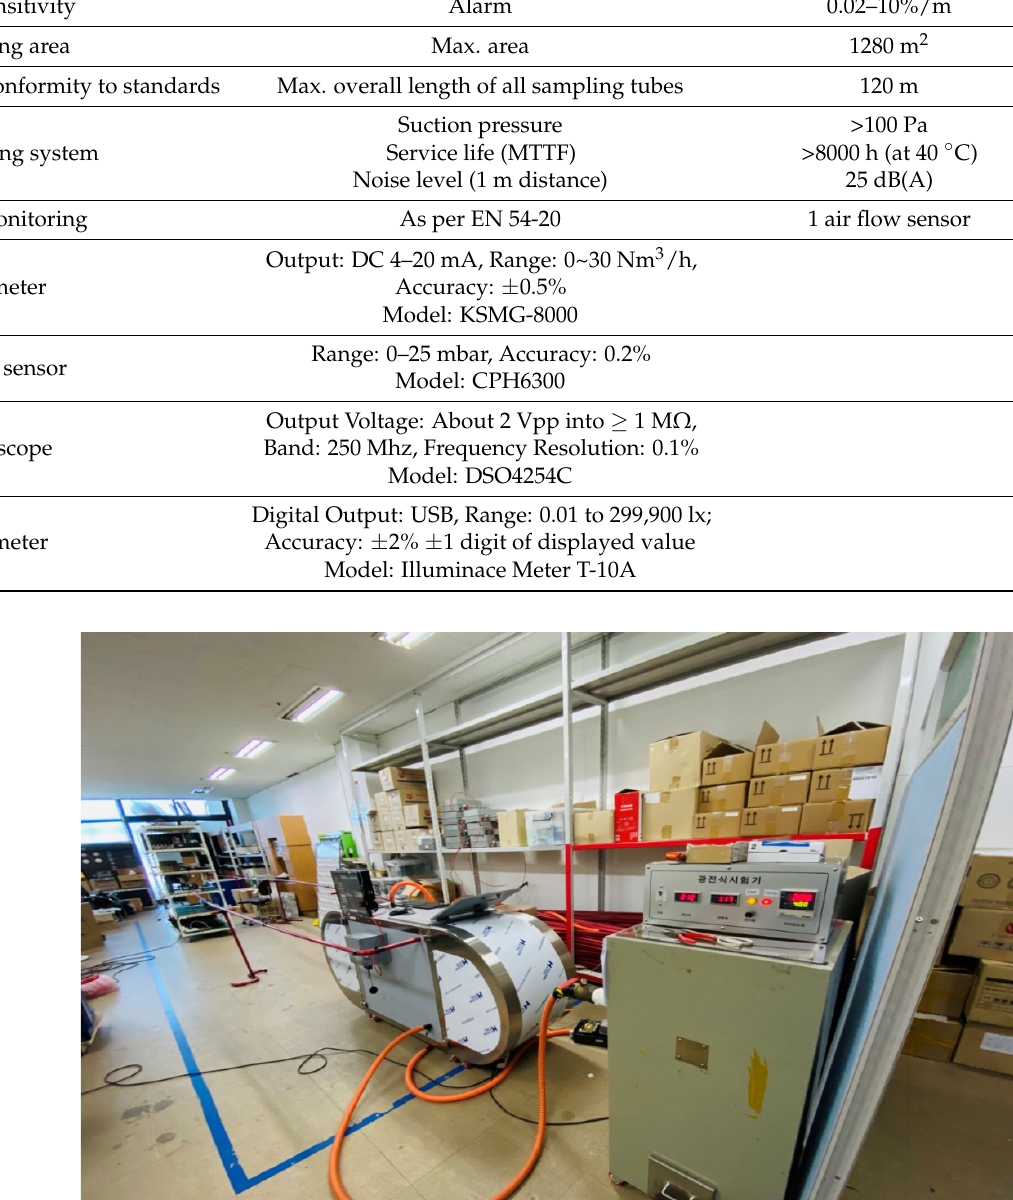
Table A1. Specification of experimental apparatus.